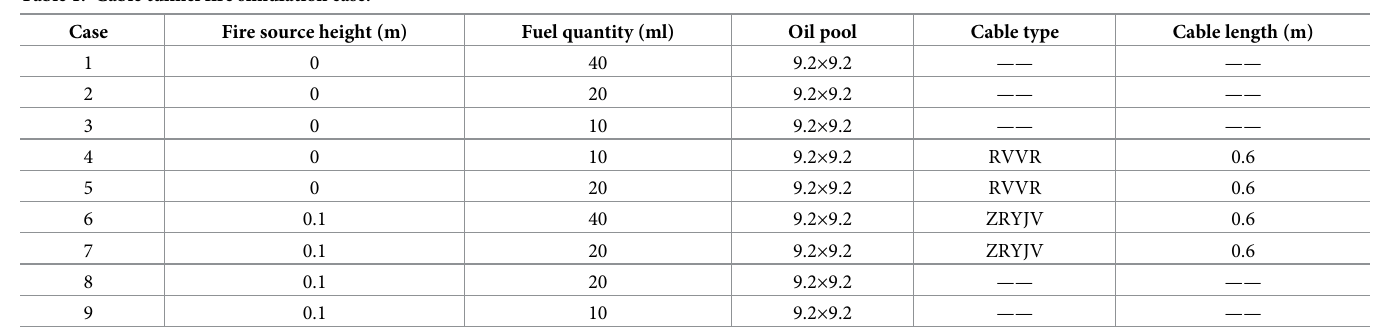
Table 1. Cable tunnel fire simulation